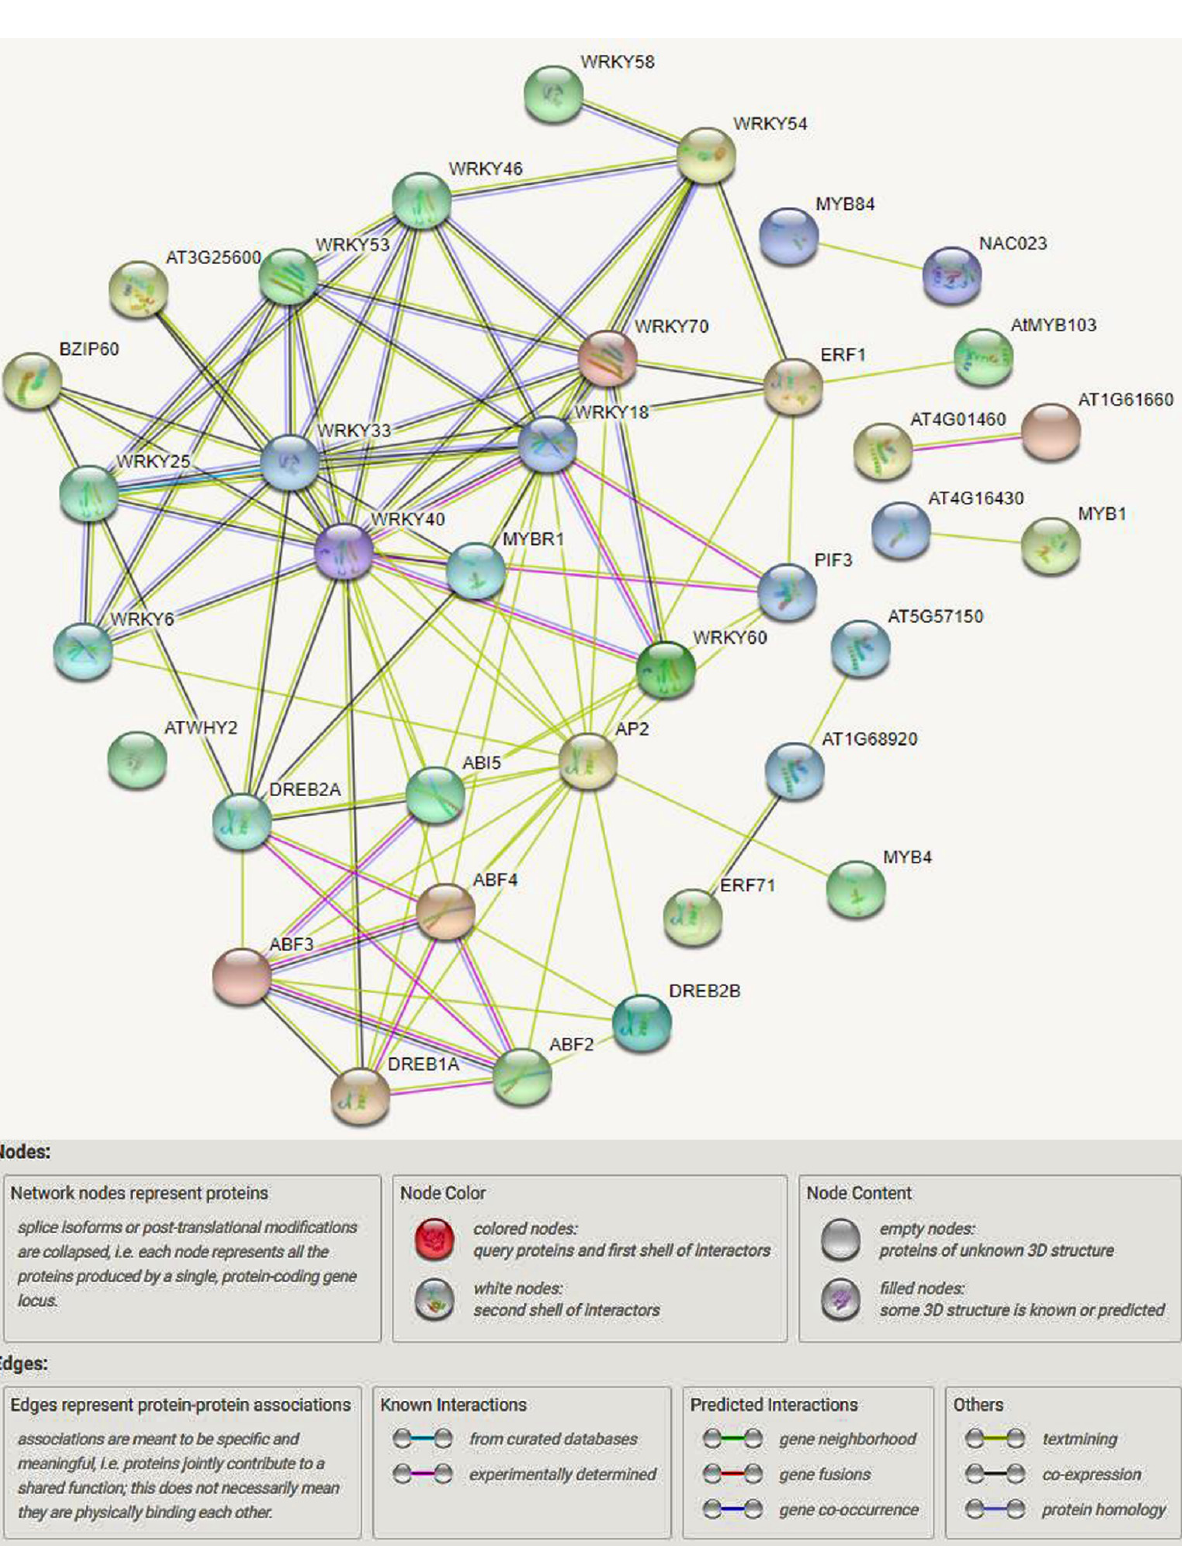
Figure 5. Genetic regulatory network constructed for drought and salinity tolerance genes. The figure shows different interactions, such as gene neighborhood, fusions, co-occurrence, text mining, co-expression, and protein homology. For example, green represents the gene neighborhood, red represents gene fusion, blue represents gene co-occurrence, yellow represents text mining, and black represents co-expression.